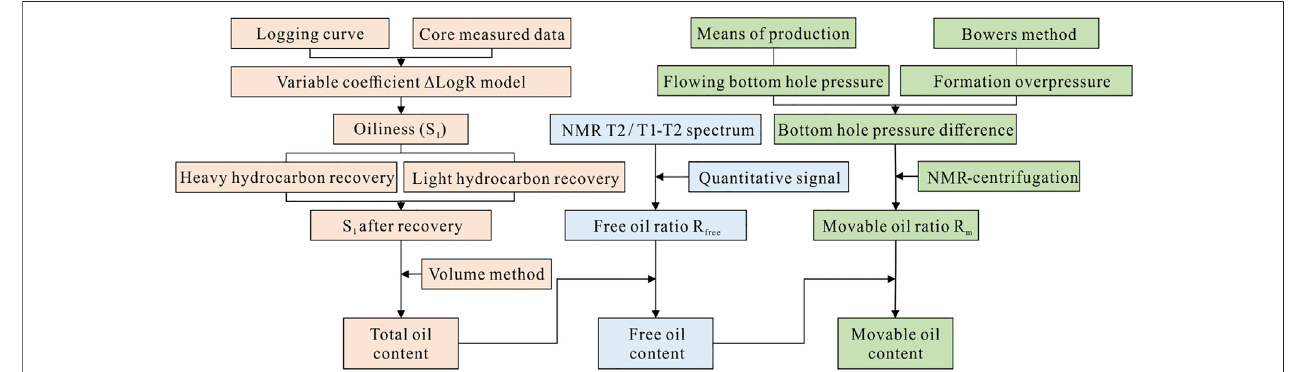
FIGURE 1 | Movable shale oil resources evaluation work fl ow.